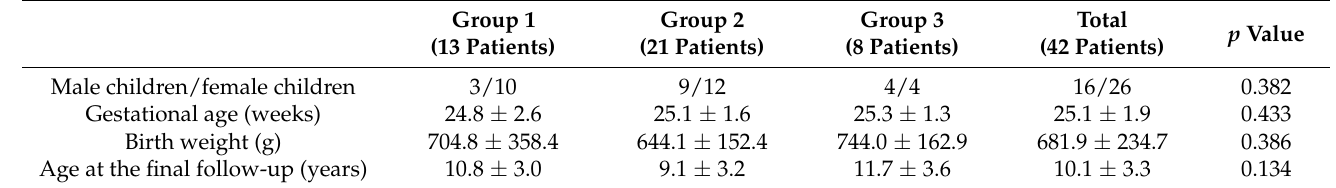
Table 1. Demographic characteristics of patients who underwent successful lens-sparing vitrectomy for stage 4A retinopathy of